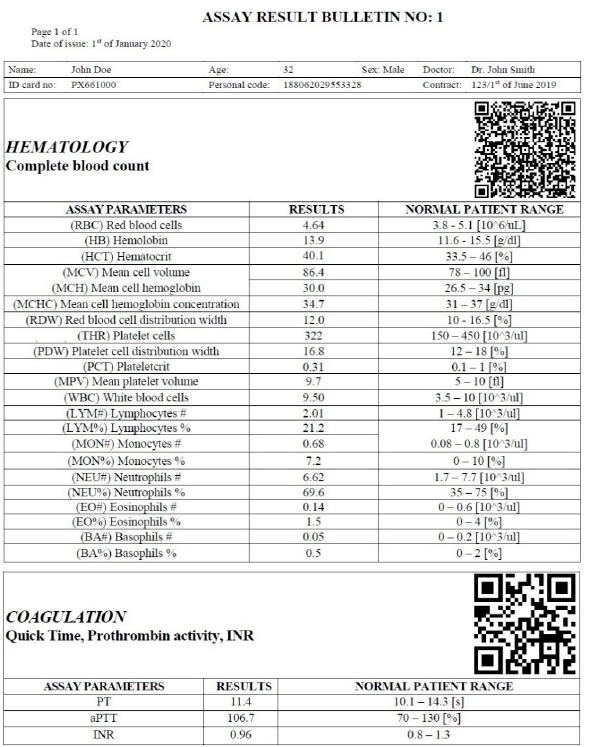
Figure 2. Example of the proposed standardized quick response (QR) code embedded in the result bulletin for a set of hematology and coagulation blood assays results issued by the laboratory.